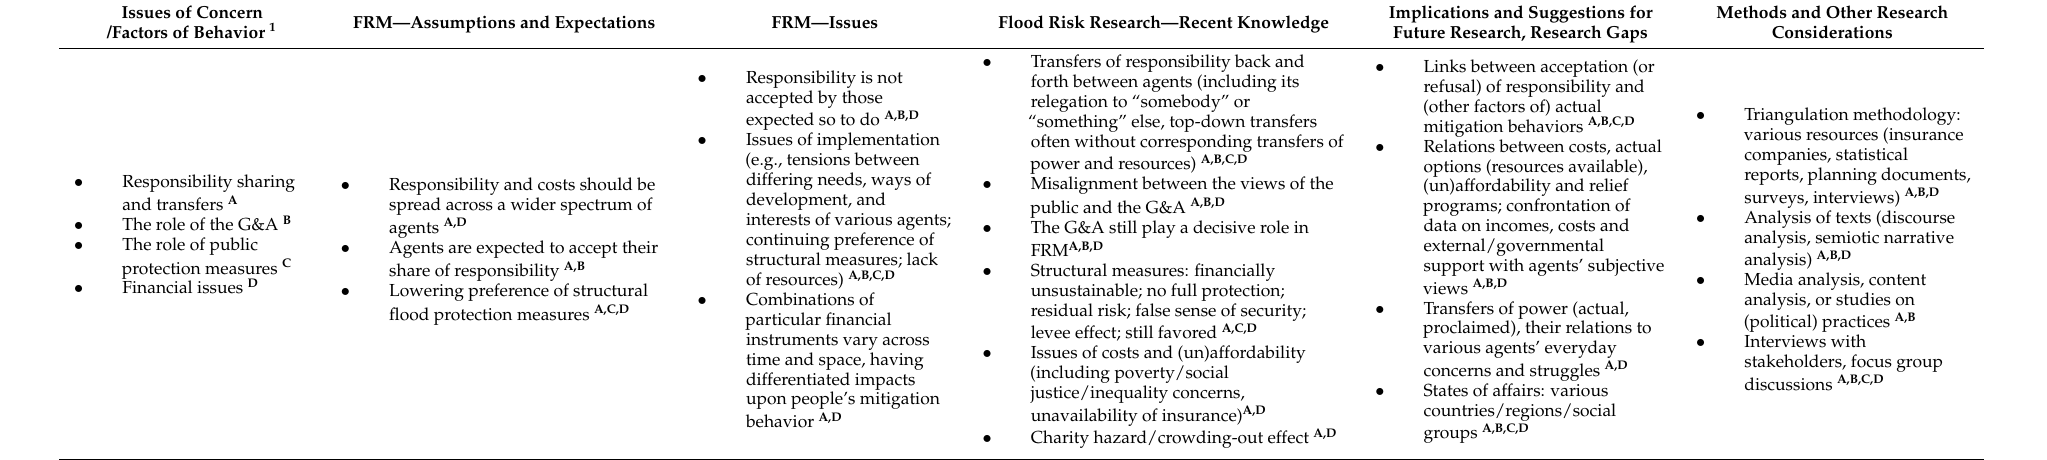
Table 3. Responsibility–overview of findings, implications, and suggestions for future flood risk research